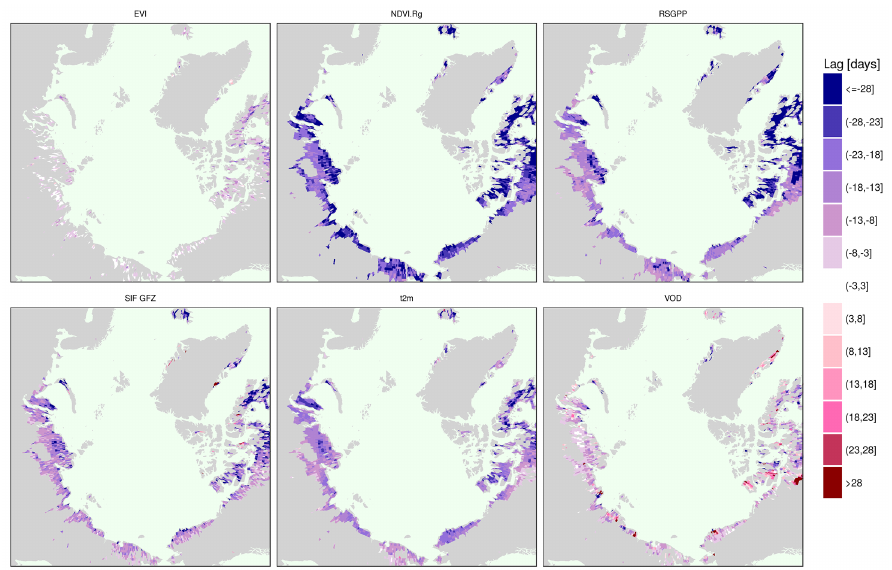
Figure A4. Average time difference of the yearly maximum across years between selected vegetation proxies and the NDVI based on 50 bootstrap samples of each year’s time series. Shown are only statistically significant differences at a level of